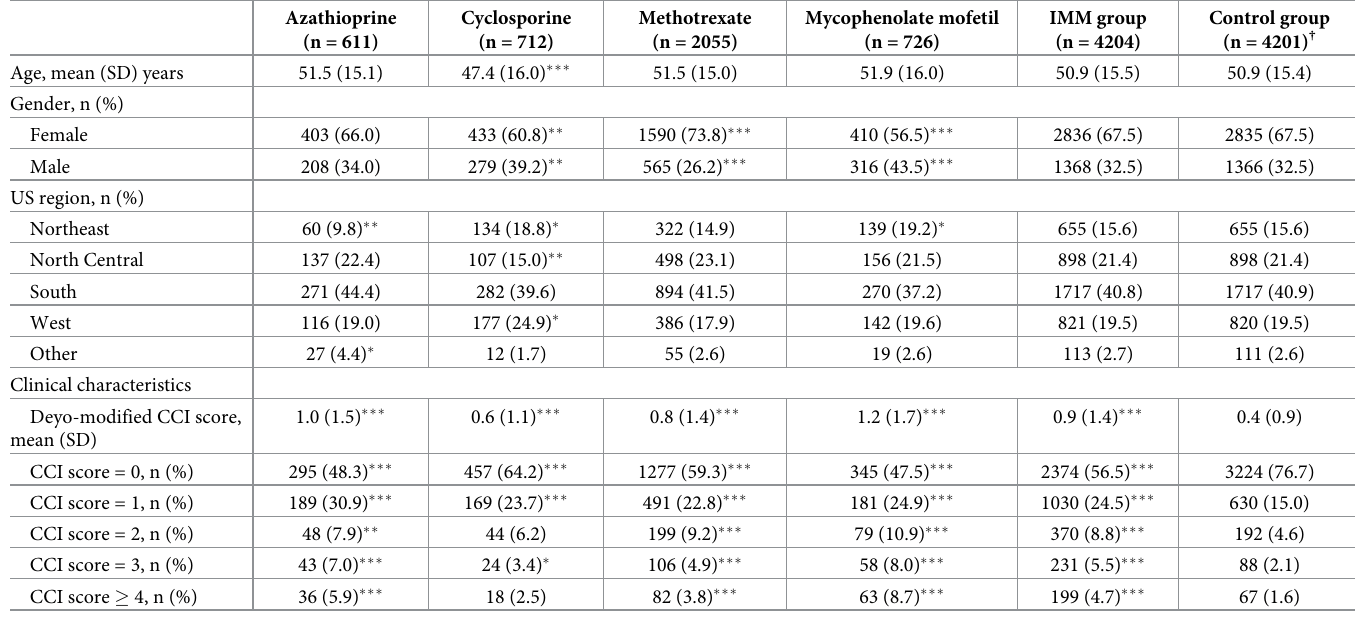
Table 1. Baseline patient